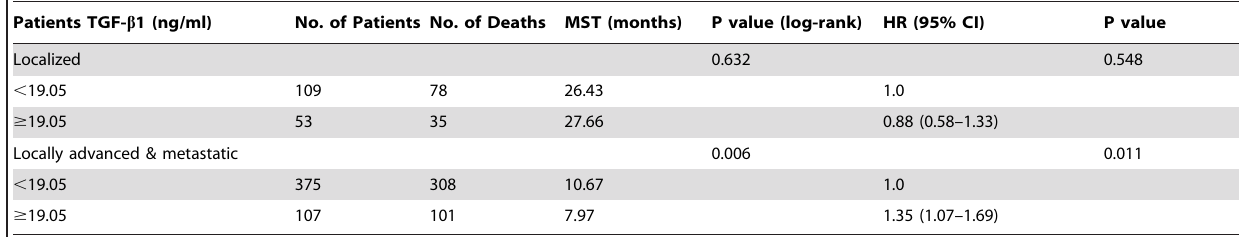
Patients TGF- b 1 (ng/ml)